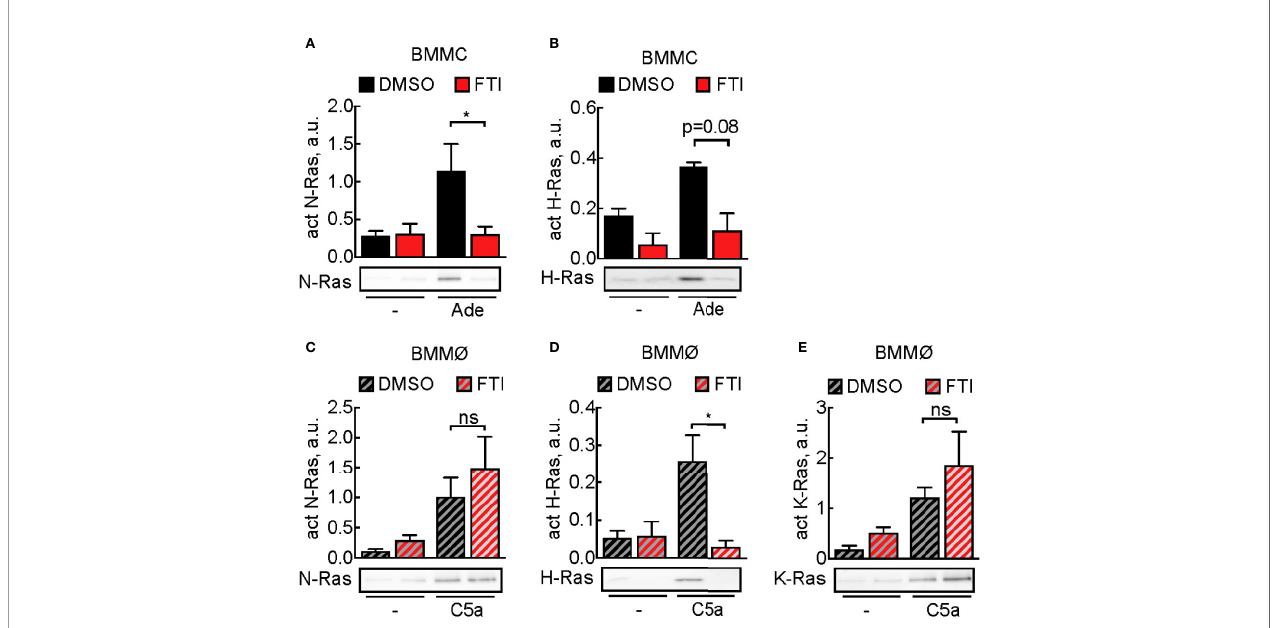
FIGURE 4 | Prevention of activation of Ras isoforms by FTI-277. (A, B) Effect of FTI-277 on N-Ras and H-Ras activation in BMMCs. Cells were treated with DMSO or 5 µM FTI-277 for 72 h. Activated N-Ras and H-Ras was pulled down with GTP-Raf-RBD and normalized to Ras amount in complete cell lysate. (C – E) Effect of FTI-277 on N-Ras, K-Ras, and H-Ras activation in BMMØs. BMMØs cultured for 5 days were treated with DMSO or 5 µM FTI-277 for 72 h. Every quanti fi cation contains n = 3 – 6 Ras activation assays, and one representative immunoblot is shown for each condition. Student ’ s t-test was applied for statistical